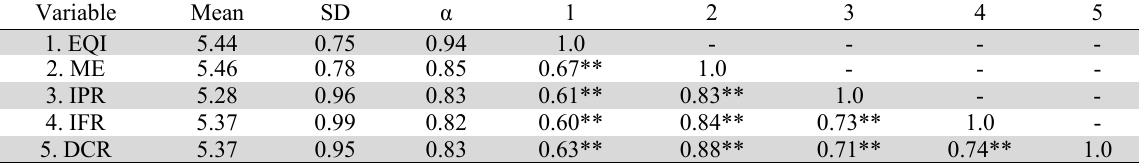
Means, Standard Deviations, Reliabilities, and Correlations among Variables Variable